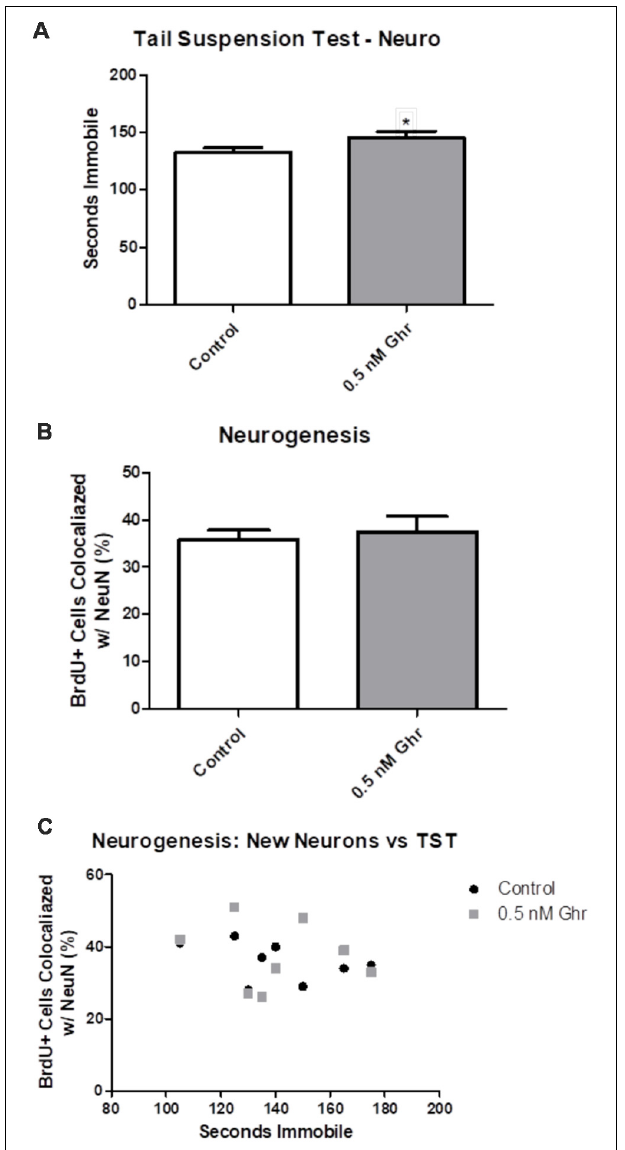
FIGURE 8 | Neurogenesis and the TST. (A) TST for the neurogenic paradigm. (B) Number of cells that contained both BrdU and NeuN, as quantified using confocal microscopy. (C) Linear comparison of the TST to the percentage of BrdU positive cells that were co-localized with NeuN. Values expressed as mean + SEM ( ∗ p <